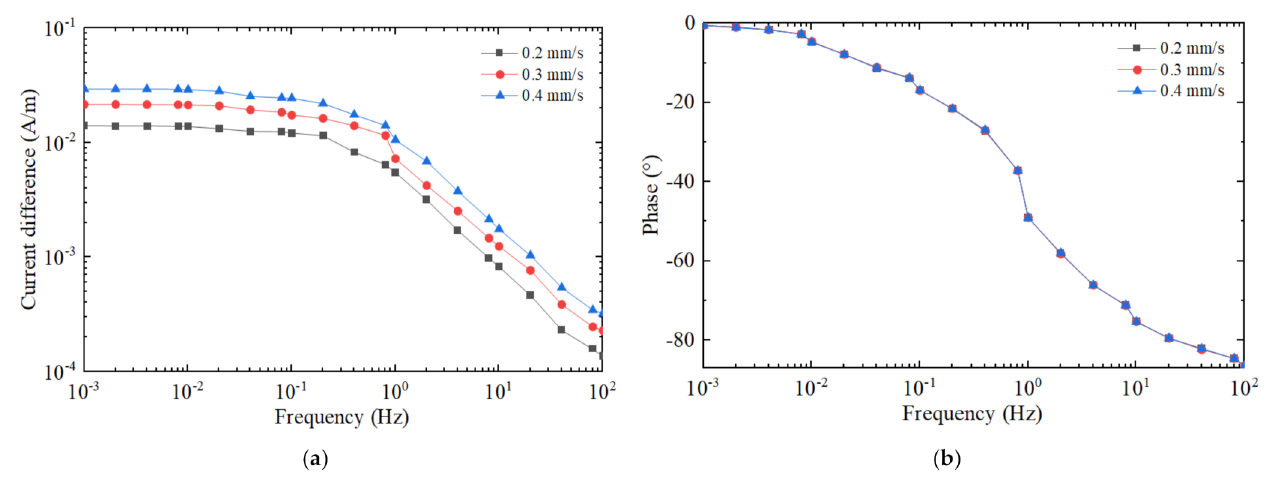
Figure 5. The output responses at different jet flow velocities in the frequency domain. The jet flow velocity is 0.2 mm/s, 0.3 mm/s and 0.4 mm/s, respectively. ( a ) Amplitude–frequency response. ( b ) Phase–frequency